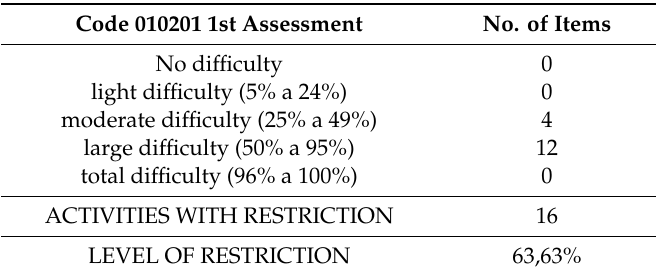
Table 6. First evaluation data for child code 010201, 11 years old.